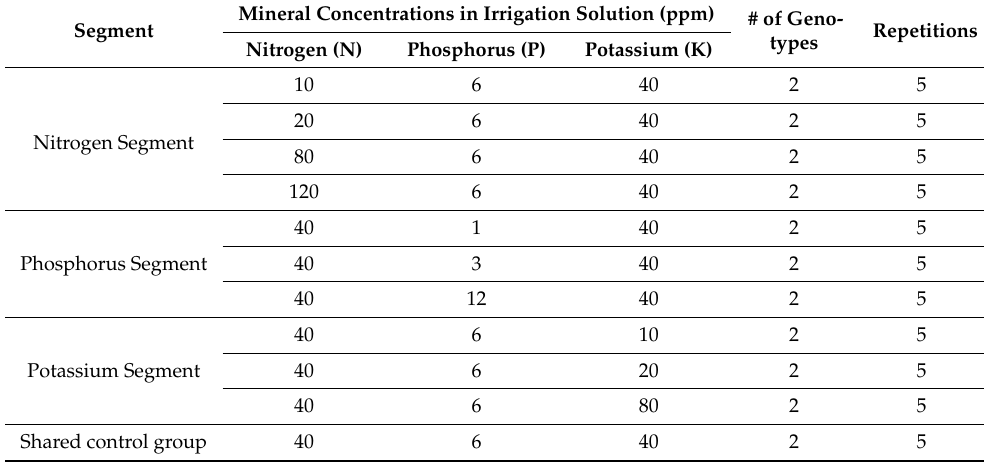
Table A1. List of treatments in winter pot experiment, including N treatments reported by Gashu et al. 2020.